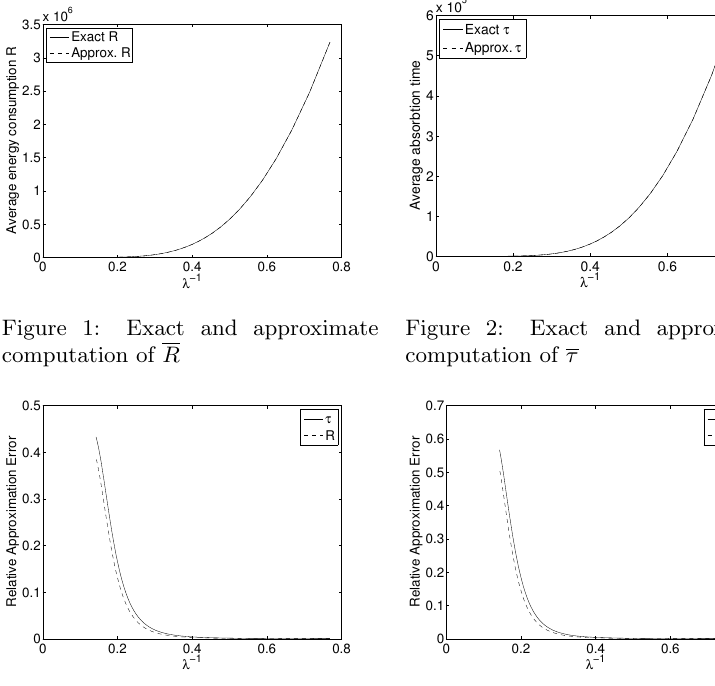
Figure 4: Relative approximation er- ror for R and τ , Strategy 2